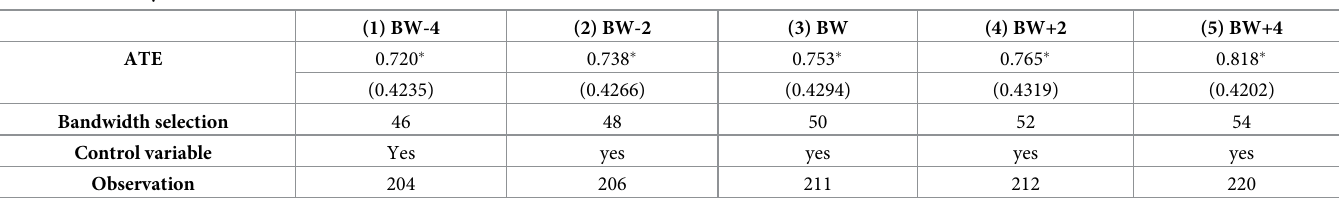
Table 5. Sensitivity test to bandwidth choice.